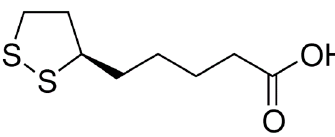
Figure 1. Chemical structure of α -lipoic acid (LA). The molecular formula of LA is C 8 H 14 O 2 S 2 , molecular weight is 206.326, molar refractive index is 54.94, molar volume is 169.3 m 3 /mol, and parachor (90.2 K) is 456.4.